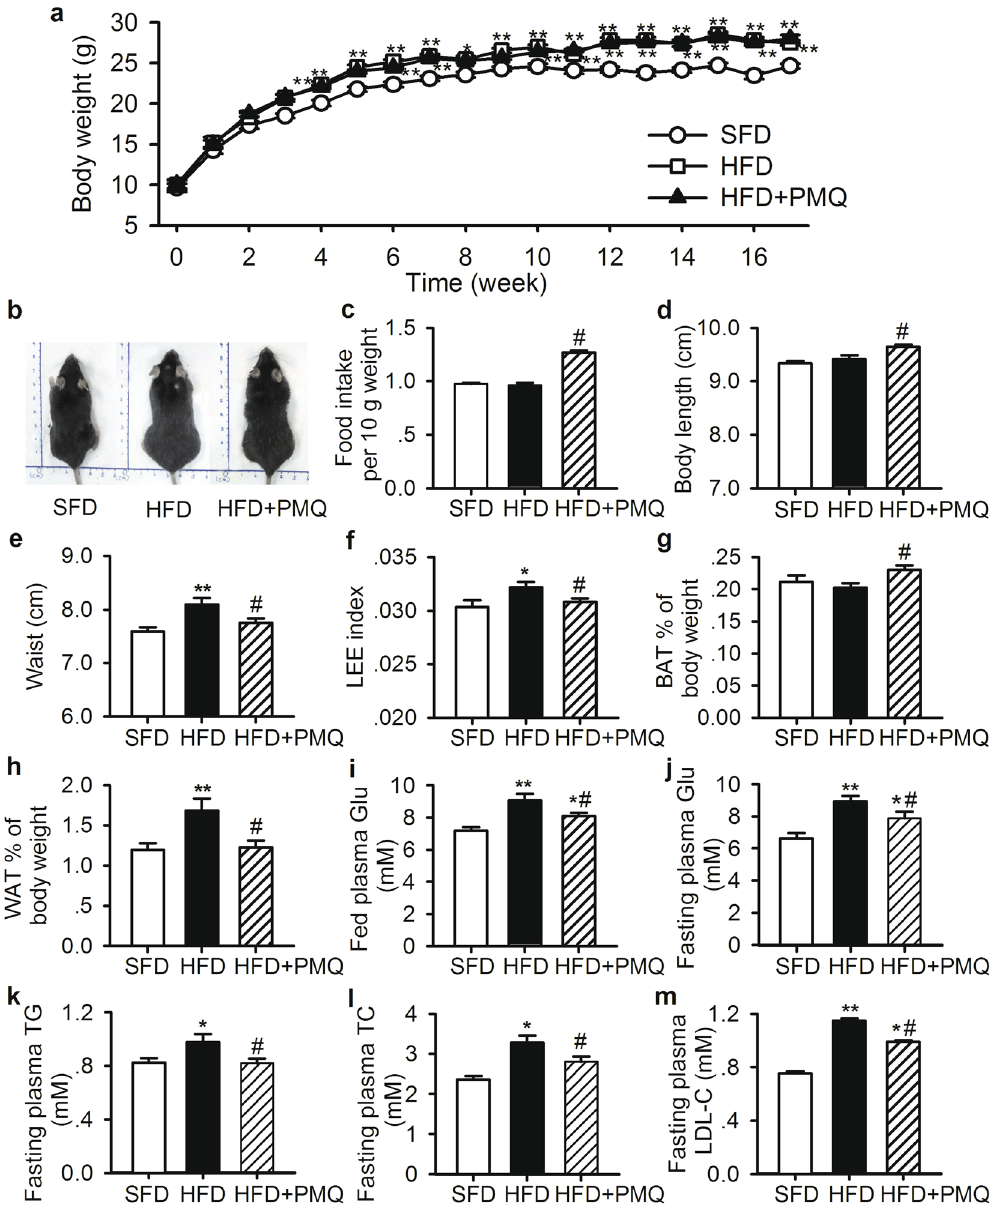
Figure 5. PMQ protected mice against high fat diet-induced obesity. ( a ) Body weights, ( b ) representative images, ( c ) food intake, ( d ) body length, ( e ) waist circumference, ( f ) LEE index, ( g,h ) interscapular BAT and epididymal WAT weight, ( i ) fed plasma glucose levels, ( j ) fasting plasma glucose levels, ( k ) TG levels, ( l ) TC levels, and ( m ) LDL-C levels of HFD mice. The data are expressed as the mean ± SEM. n = 10 experiments, * p < 0.05 ** p < 0.01 vs SFD; # p < 0 .05 vs